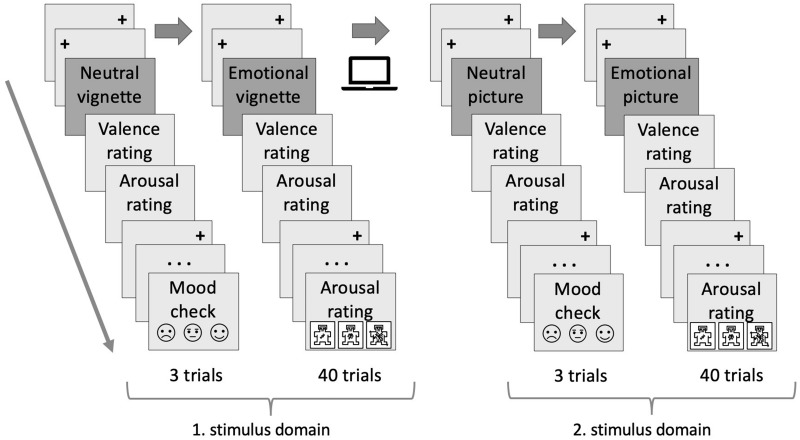
Graphic depiction of the experimental procedure. Participants performed an evaluative judgment task on textual and pictorial stimuli, respectively. The order of stimulus domains (i.e., pictorial, textual) was balanced across participants. To ensure comparable initial situations, each experimental session started with the presentation of three emotionally neutral stimuli. At the beginning of each trial, two serially presented fixation crosses had to be looked at for 500 ms. After assessing participants’ mood, 40 emotionally valenced stimuli were sequentially displayed while recording eye movements. Pictures were viewed for a fixed period of 3 s. Reading of vignettes was self-controlled. Ratings of perceived valence and arousal were measured using a 9-point Self-Assessment-Manikin scale (SAM; Lang, 1980; Suk, 2006). After completion of the first presentation block, an online survey was conducted.